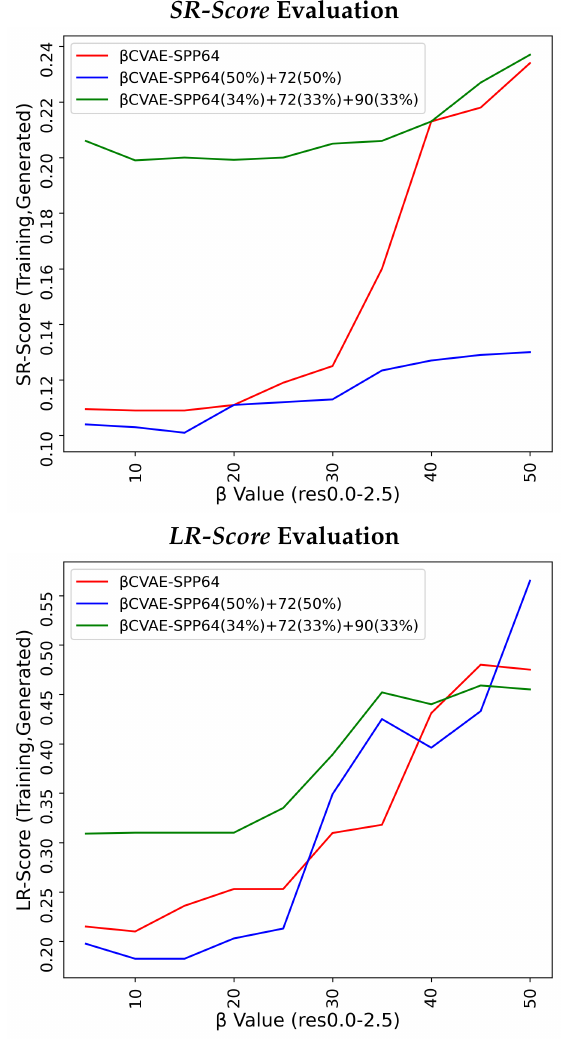
Figure 2. Varying β in [ 5,50 ] in increments of 5. Each resulting β -CVAE-SPP model is trained separately on each of the 3 training dataset configurations built over the res0.0-2.5 input dataset. Data generated by each model are compared to the respective training dataset via EMD over % Backbone (top panel), SR-Score (middle panel), and LR-Score (bottom